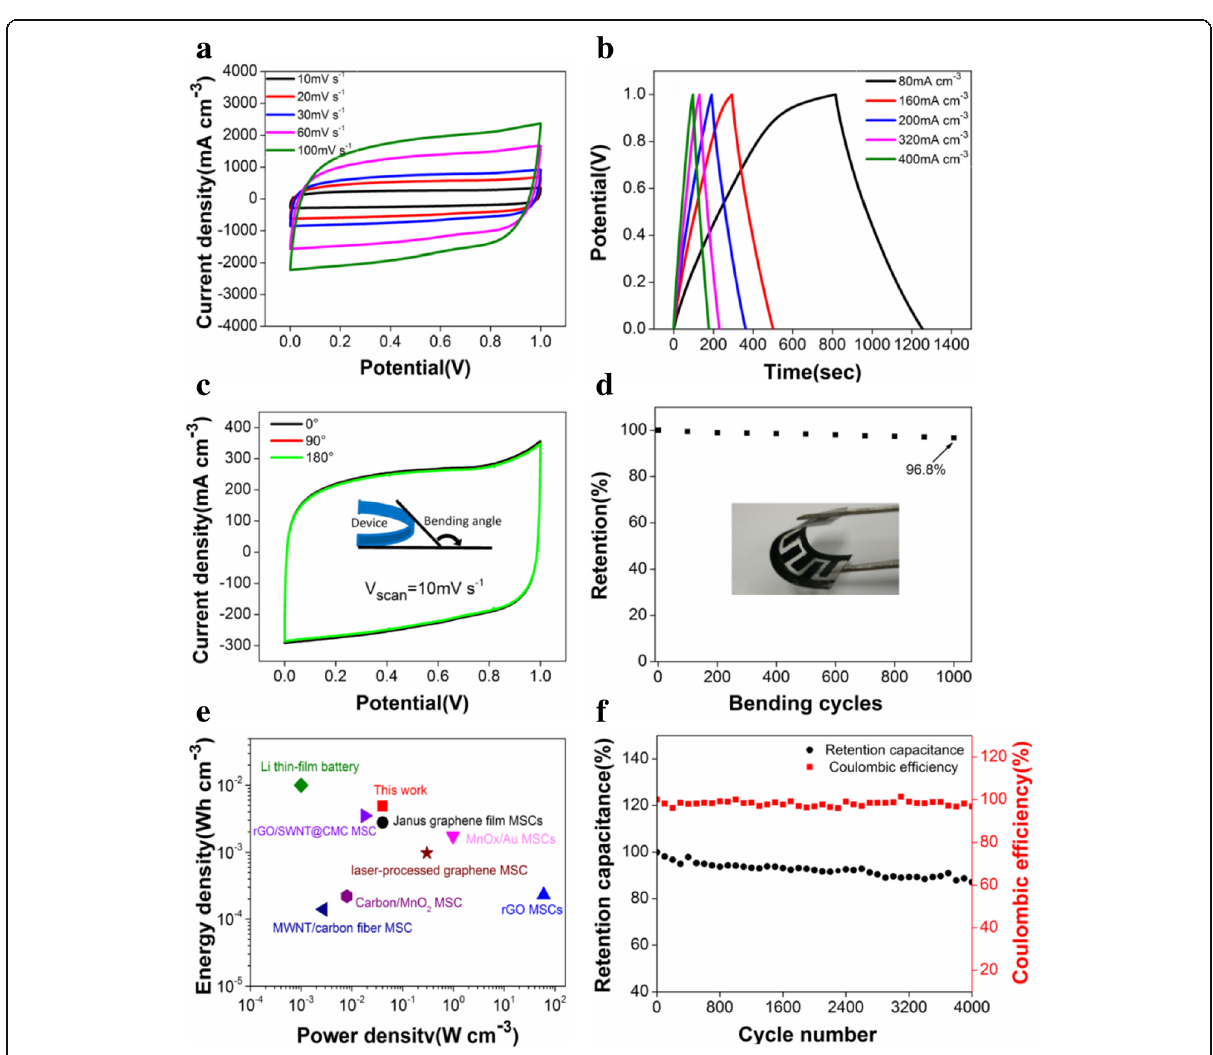
Fig. 6 The electrochemical performances of rGO/PEDOT-50-based flexible all-solid-state MSCs: a CV curves at various scan rates; b GCD curves at different current densities; c CV curves obtained under different bending angles at 10 mV s − 1 ; d Capacitance retention as a function of bending cycles at a current density of 80 mA cm − 3 ; e Ragone plots of the device and some other reported MSCs, and f cyclability tests and coulombic efficiency over 4000 charge/discharge cycles at a current density of 80 mA cm −